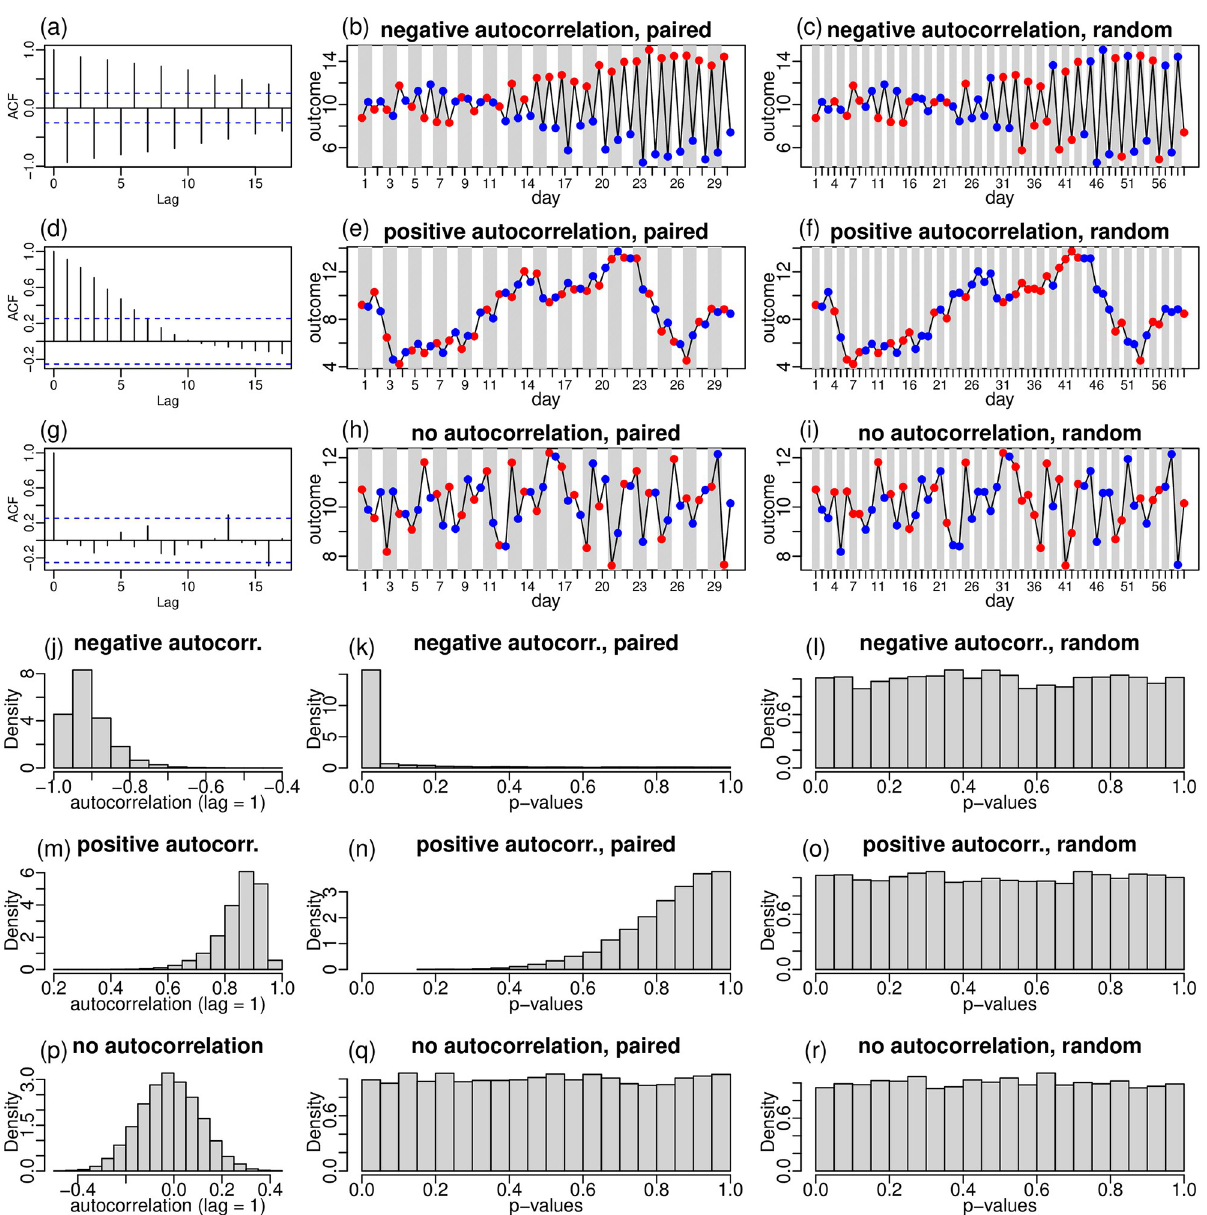
Fig 5. The effect of autocorrelation on t-tests. Here, we illustrate the effect of autocorrelation on t-tests using synthetic data simulated under the null hypothesis of no medication (or time-of-the-day effects). Panels a-c illustrate the negative autocorrelation case. Panel a shows the autocorrelation plot, of the outcome variable time series shown on panels b and c. Panel b show the time series for the outcome variable in the paired case. Panel c shows the same time-series on the random case. Red and blue dots correspond to activities performed “before” and “after” the participant has taken medication. Panels d-f illustrate the positive autocorrelation case, while panels g-i illustrate the no autocorrelation case. Panels j-l, m-o, and p-r, show the distributions of the empirical autocorrelation (lag = 1) estimates, and of t-test p-values, from 10,000 replications of the negative, positive, and no autocorrelation examples,